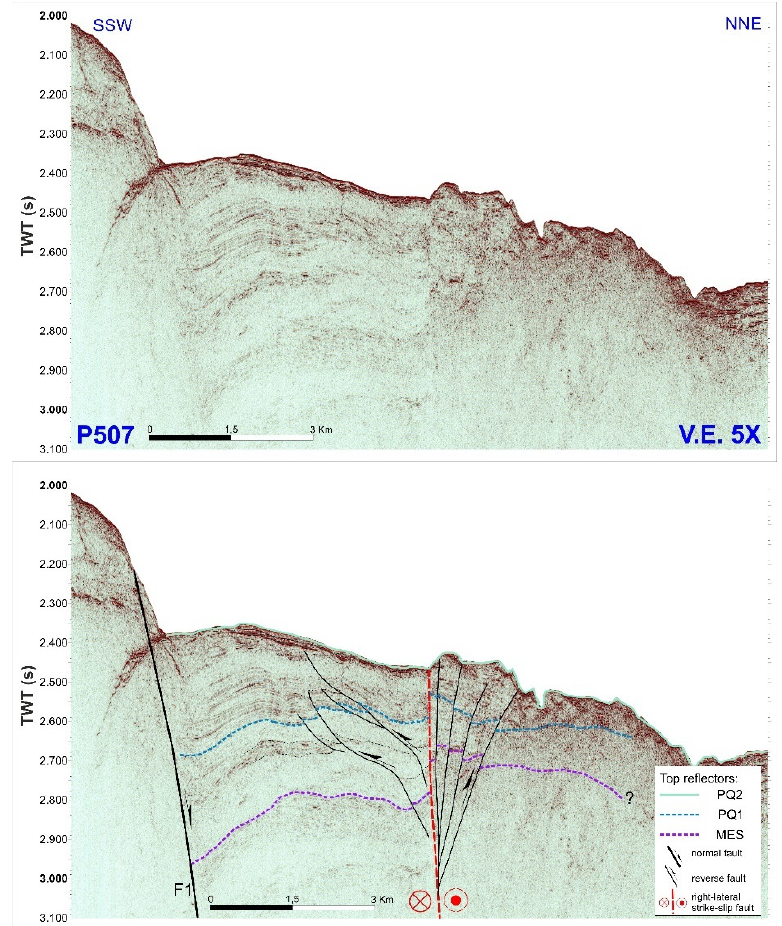
Figure 8. The p507 seismic profile and its interpretation below (see location in Figure 5).